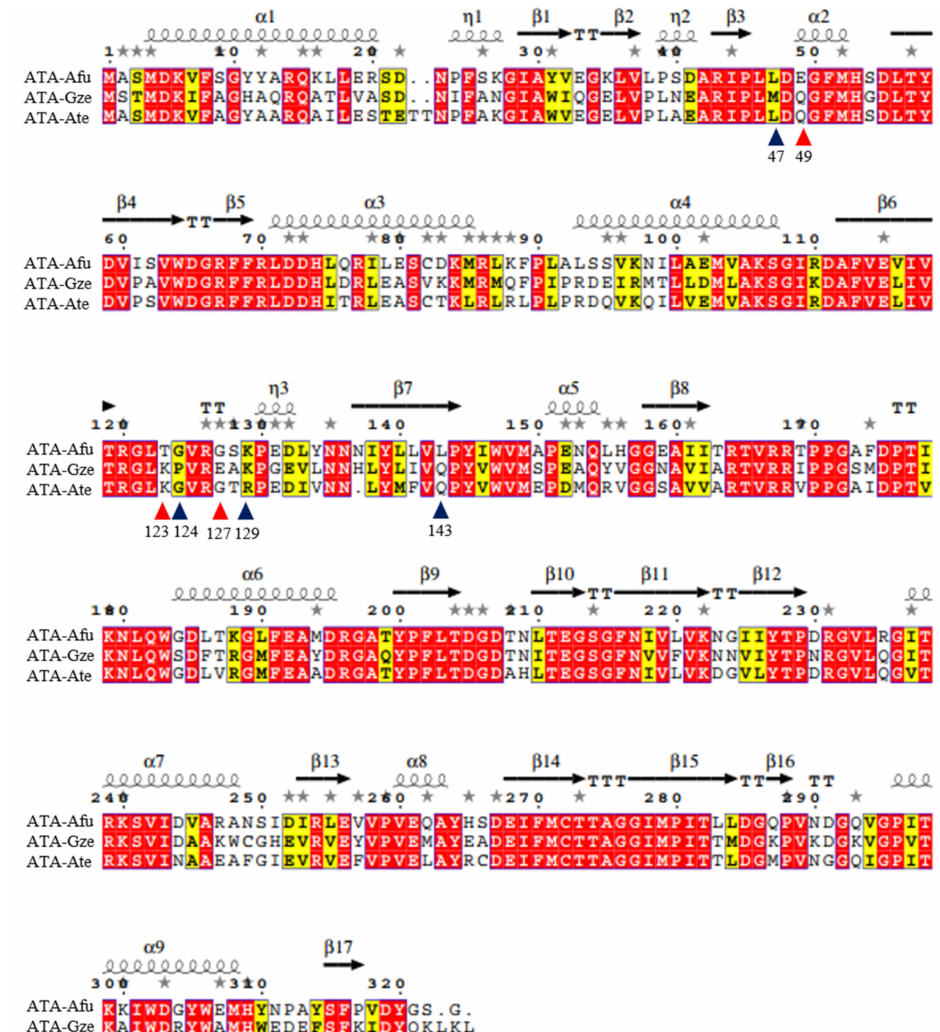
Figure 1. Amino acid sequence alignments of ATA-Afu, ATA-Gze and ATA-Ate. The residues in the substrates tunnel area are marked with triangles. Among them, E49, T123 and G127 present in ATA-Afu (red colored triangles) have differently charged side chains compared to the other two ATAs. The red box and white character mean that the residues are identical. The yellow box and black character mean that the residues are similar in size and charge. The figure was created using the online alignment tools Cobalt [47] and ESPript 3.0